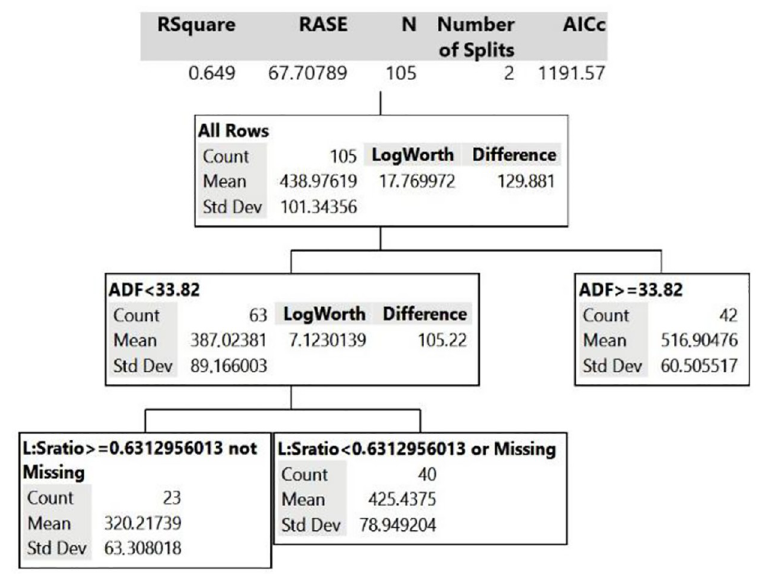
Fig 3. Decision Tree model for grazing time behavior variable of the animal grazing guinea grass + pigeon pea (GP canopy).